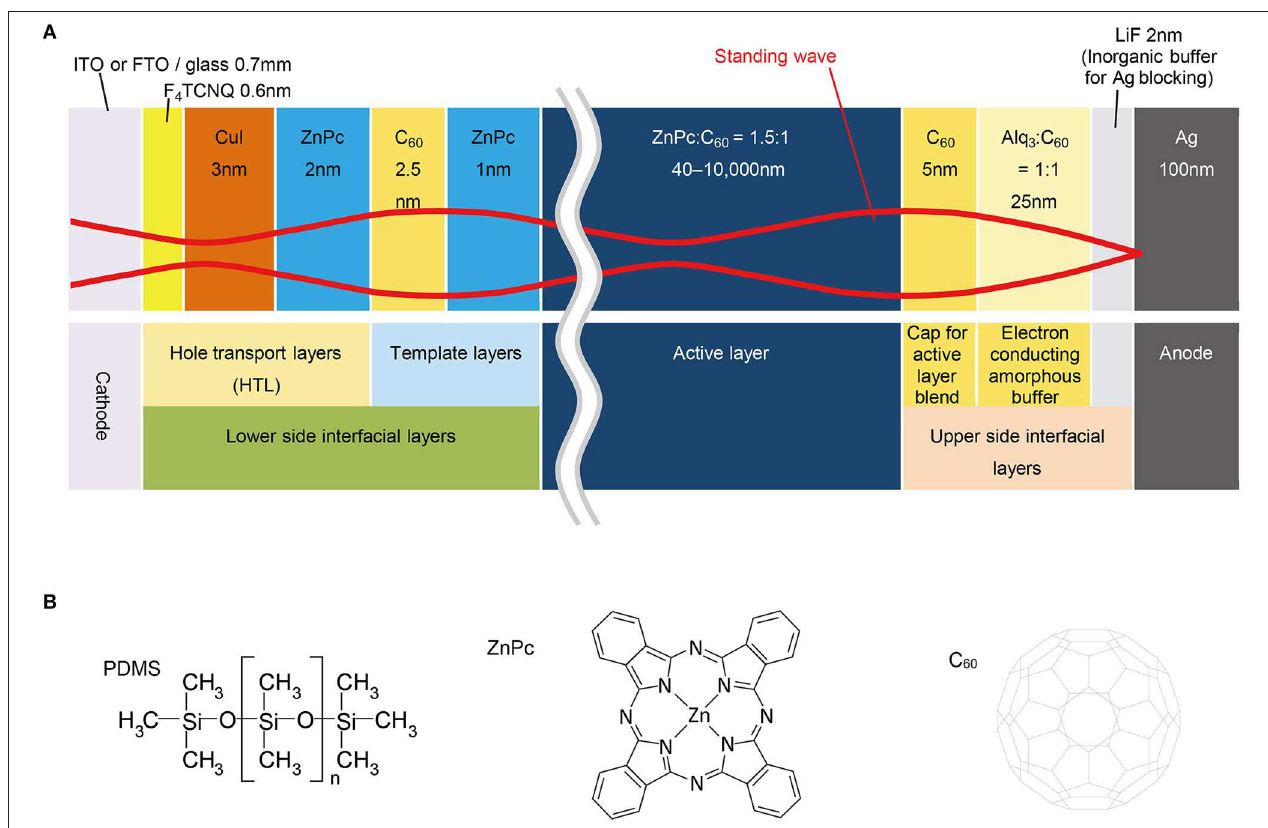
FIGURE 2 | Device structure and materials. (A) Device structure of OPVs schematically drawn with the standing wave. (B) Chemical structures of co-evaporant (PDMS) and active layer materials used in this